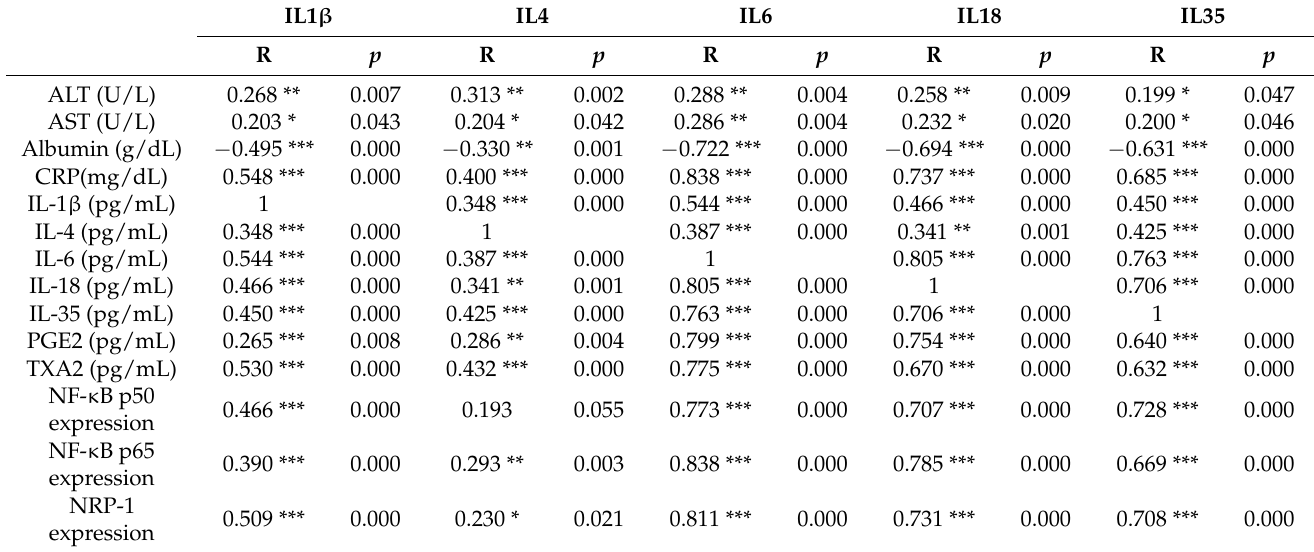
Table 5. Correlation between IL1 β , IL4, IL-6, IL-18, and IL-35 with all parameters in the severe group.